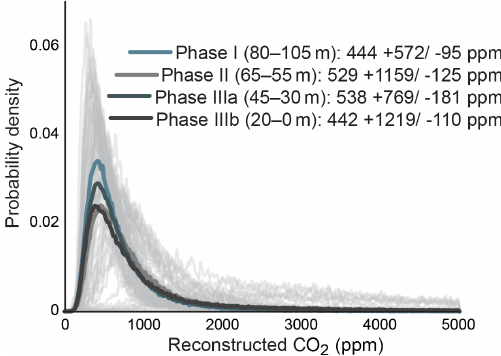
Figure 3. Probability density distributions of C a reconstructions using a gas-exchange model (Franks et al., 2014), divided by bulk carbon isotope phases (Fig.